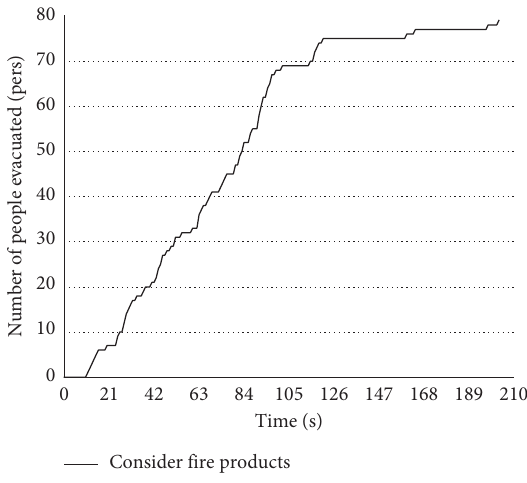
Figure 33: Exit 7 evacuation situation.